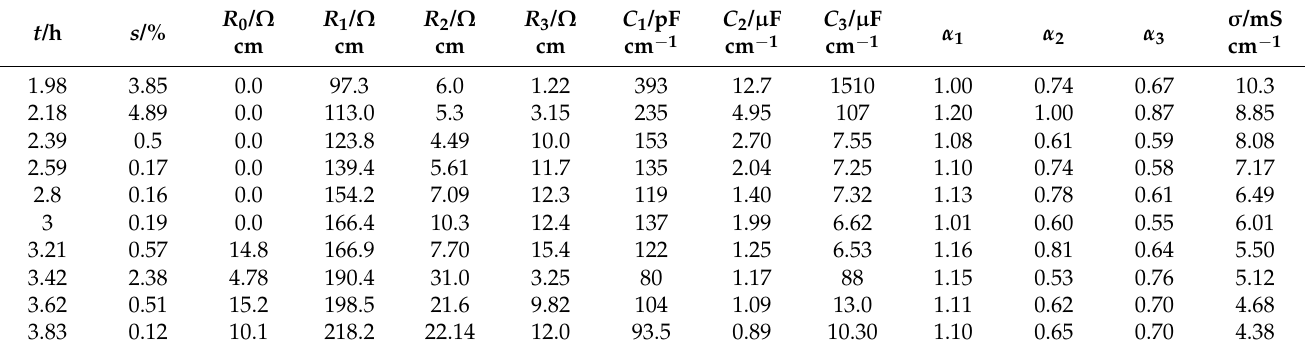
Table 8. Results of fitting the impedance spectra recorded for the Ni–5CBCY sample during oxidation in wet air and after the loss of metallic conductivity ( T —temperature; s —standard deviation; fitted parameters (for the EEC presented in Figure 14c): L —inductance; R 0 , R 1 , R 2 , R 3 —resistances; C 1 , C 2 ,